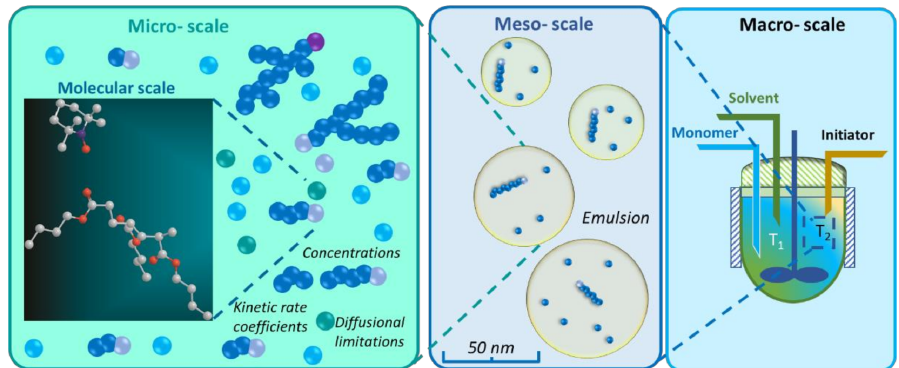
Figure 1. Scales in polymerization, leading to different calculation levels. A case is shown with particles present so that a meso-scale is